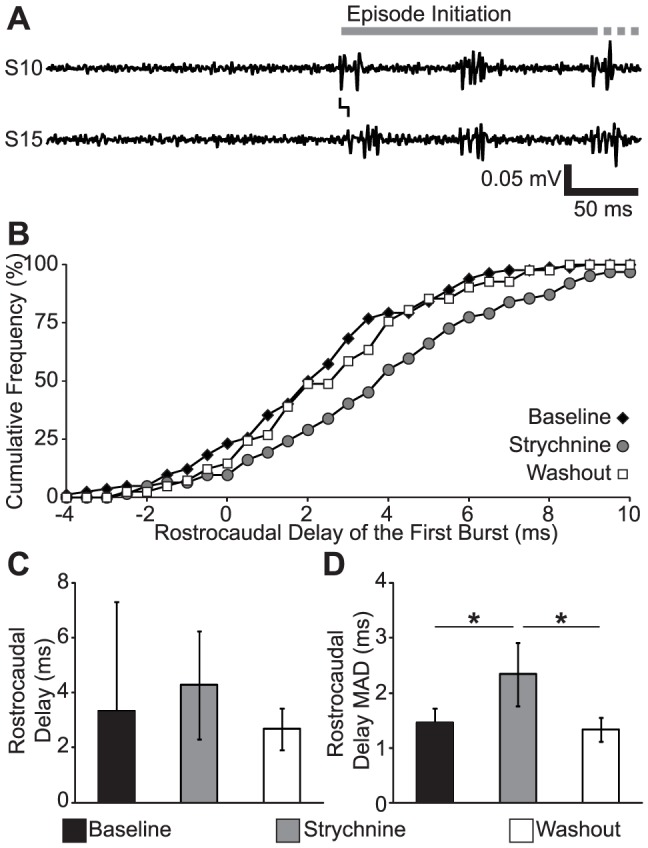
Reduced Synaptic Inhibition Significantly Reduces the Consistency of the Rostrocaudal Delay of Episode Initiation.(A) Representative traces showing the initiation of an episode of fictive swimming in Baseline conditions (spinalized, 50 µM NMDA). The gray bar shows the time in the trace occupied by the episode, the line between the traces shows the rostrocaudal delay between the first burst in the PN recordings. This episode continued past the time window shown in the trace, reflected by gray dots. (B) Cumulative histogram of rostrocaudal delay for a representative preparation in Baseline (black diamonds), Strychnine (gray circles; 50 µM NMDA, 1 µM strychnine) and Washout (white squares; 50 µM NMDA) conditions. (C–D) Plots of the mean rostrocaudal delay (C) and the MAD of rostrocaudal delay (D) against condition. * Statistically significant difference.